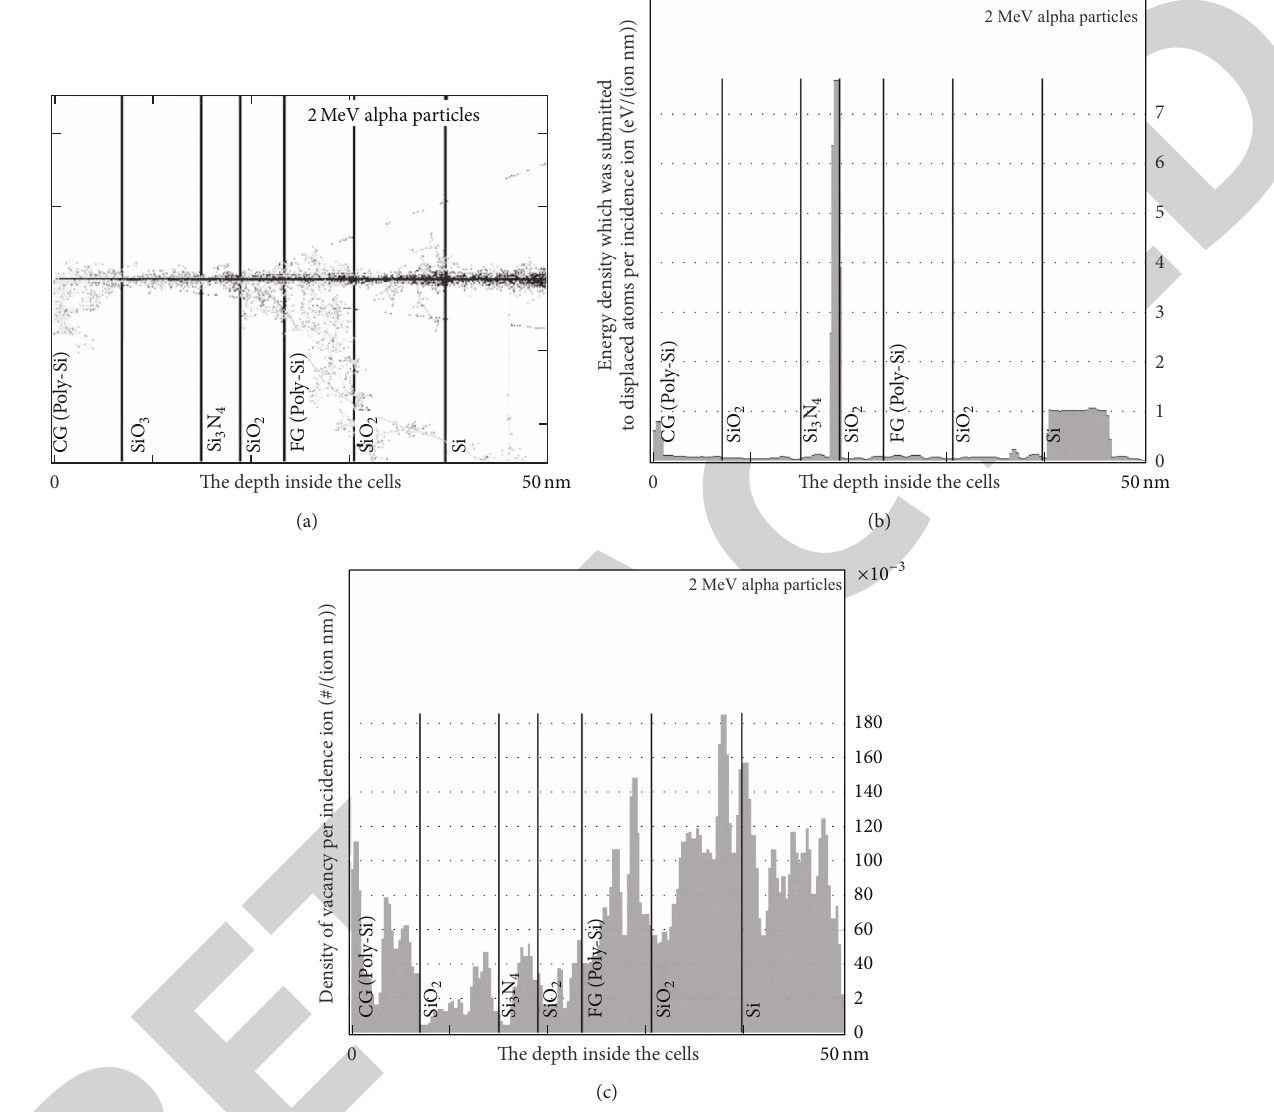
Figure 8: Results for the incident beam of 2MeV: (a) traces of particles (dark traces correspond to alpha particles, while the lighter traces are the path of the displaced ions Si, O, and N), (b) energy density of alpha particles submitted to displaced atoms, and (c) density of vacancy caused by displacement of